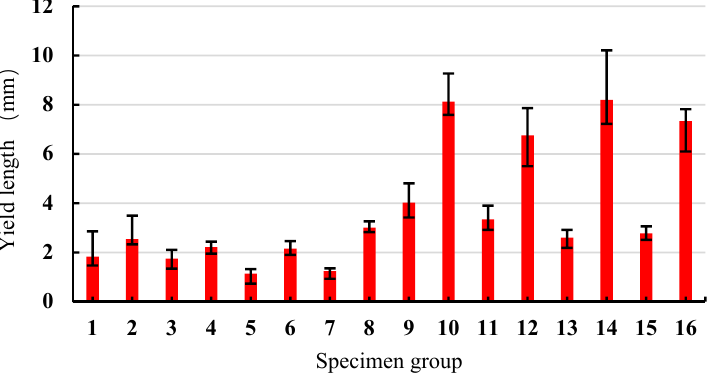
Figure 6. The initial crack and peak strengths of 16 groups of specimens.